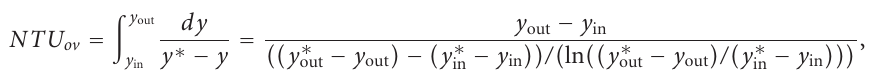
Figure 1. Air is fed with a pair of parallel compressors BC1 and BC2, D’vilbis marks 5 HP, and Twistair power of 20 HP, obtaining a maximum flow of 0053 m 3 /s of air. The pressure drop caused by the air flow through the packed bed was recorded with the di ff erential pressure meter Δ